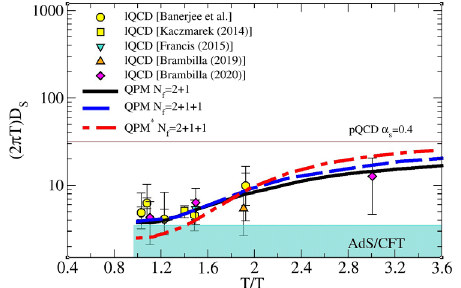
Figure 2. Spatial di ff usion coe ffi cient D s ( T ) of charm quark for standard QPM with N f = 2 + 1 flavours (black solid line), standard QPM with N f = 2 + 1 + 1 flavours (blue dashed line) and extended QPM ∗ with N f = 2 + 1 + 1 (red dot-dashed